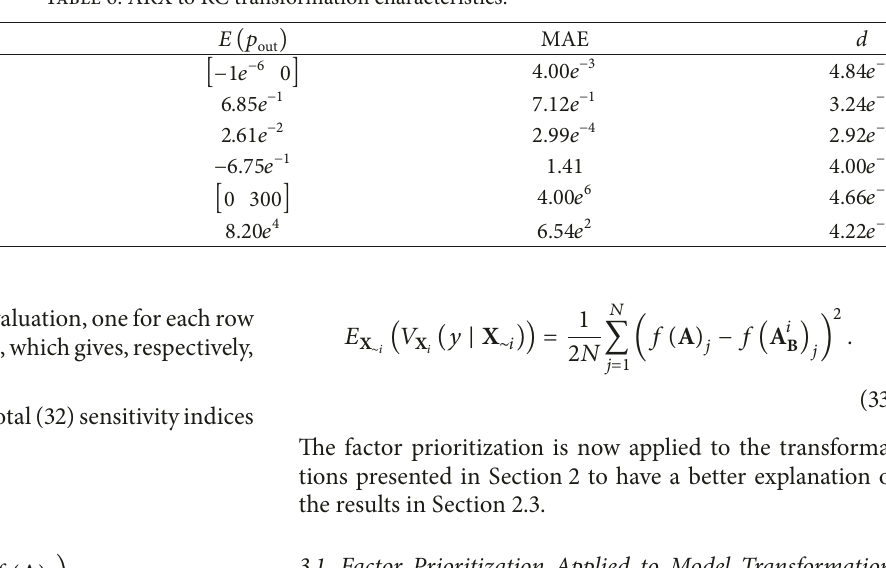
Figure 9: Histograms, ARX to RC transformation. Table 6: ARX to RC transformation